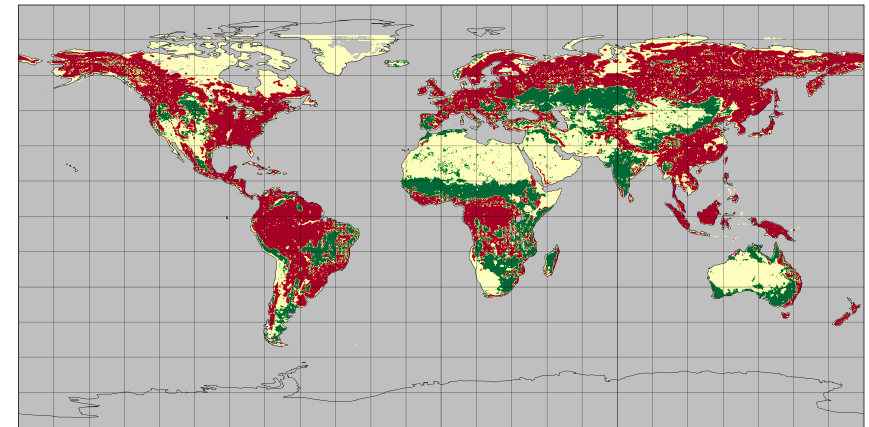
Figure 4. Global blending map illustrating where active sensors (red), passive sensors (yellow) and the average of both (green) is used to generate the ESA CCI SM product (modified from Liu et al.,